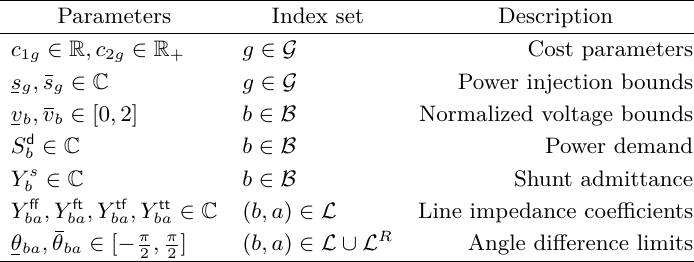
Table 1 Parameters of the ACOPF